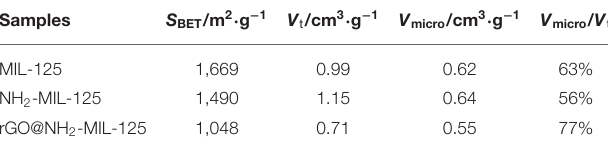
TABLE 1 | Specific surface areas and pore structure parameters of the three as-prepared samples. Samples